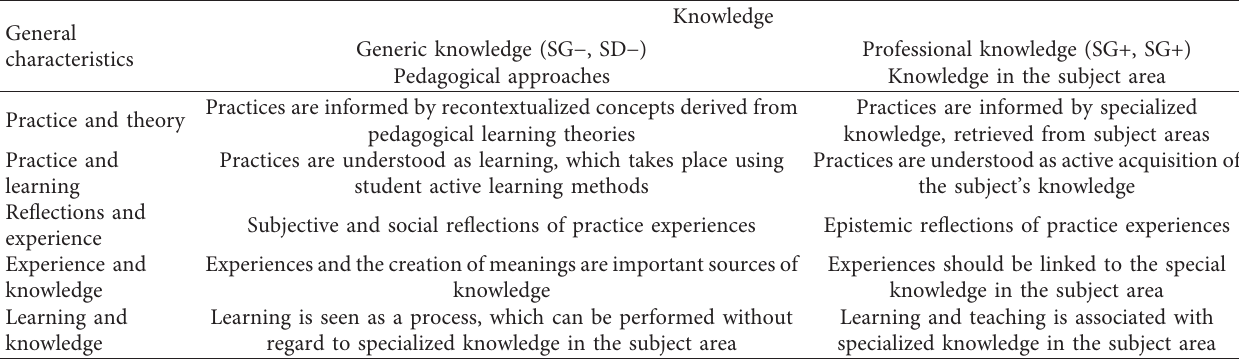
Figure 2: Forms of knowledge in students’ R&D papers. Table 3: Students’ perceptions of legitimate forms of knowledge in teacher